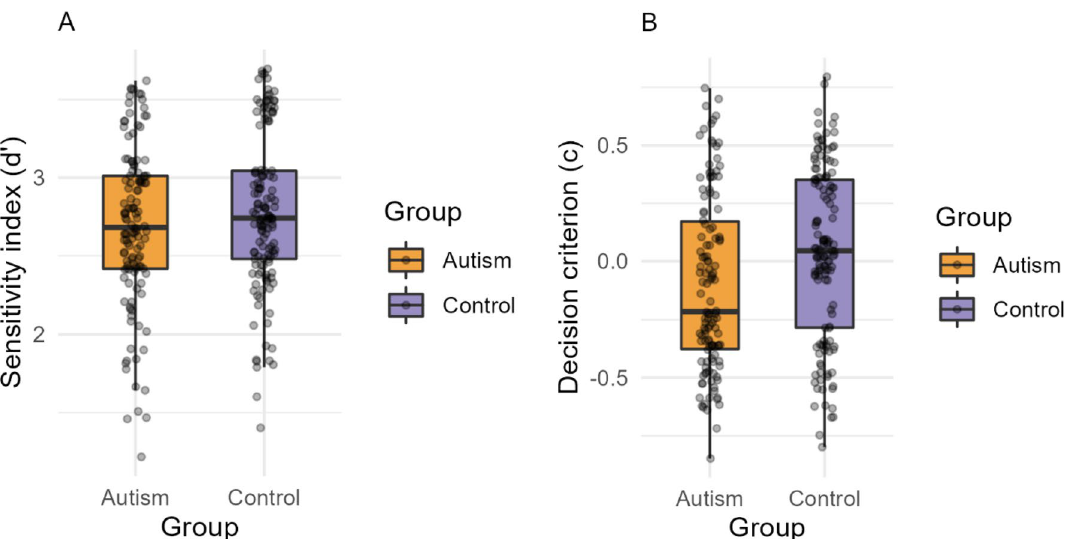
Figure 3. Task 2: Feature match. ( A ) Signal detection sensitivity index for autism and control groups. ( B ) Signal detection decision criterion values for autism and control groups. Autism group displayed in orange and control in purple. Dots indicate individual participant results. Error bars show the standard error of the